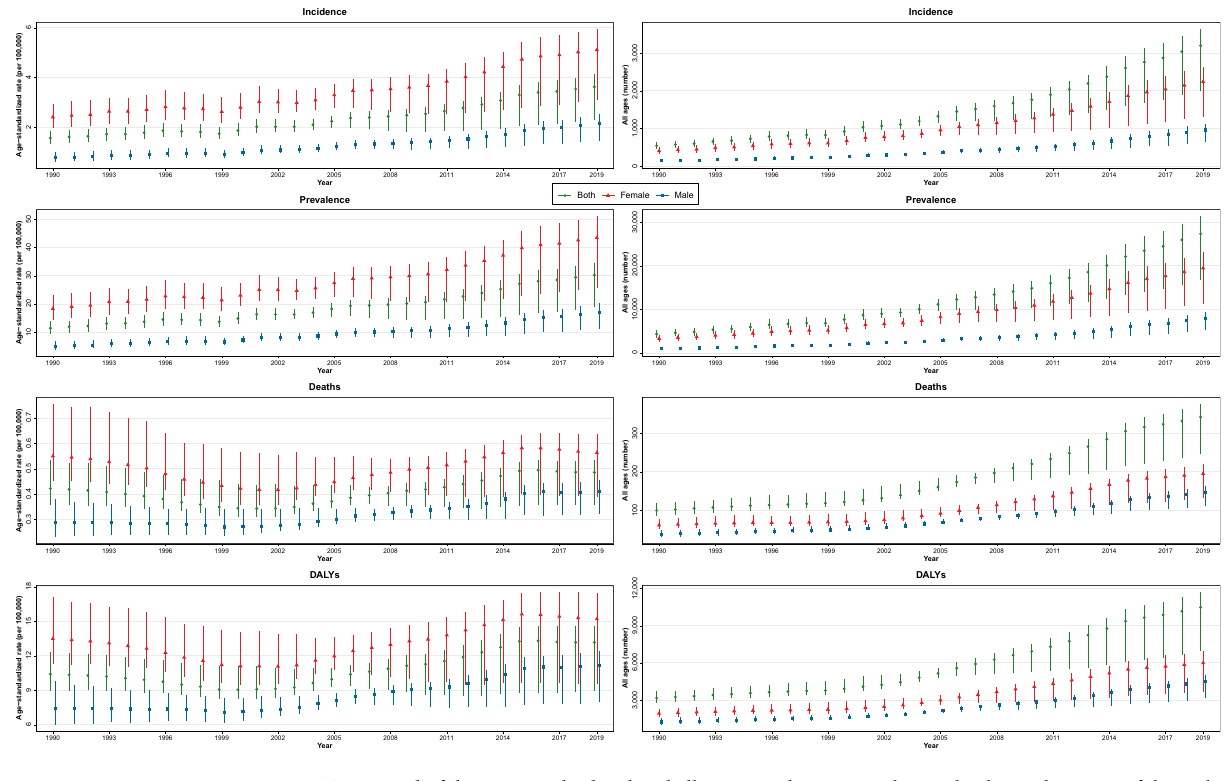
Figure 1. Time trend of the age-standardized and all-ages incidence, prevalence, deaths, and DALYs of thyroid cancer in Iran from 1990 to 2019 in by sex.